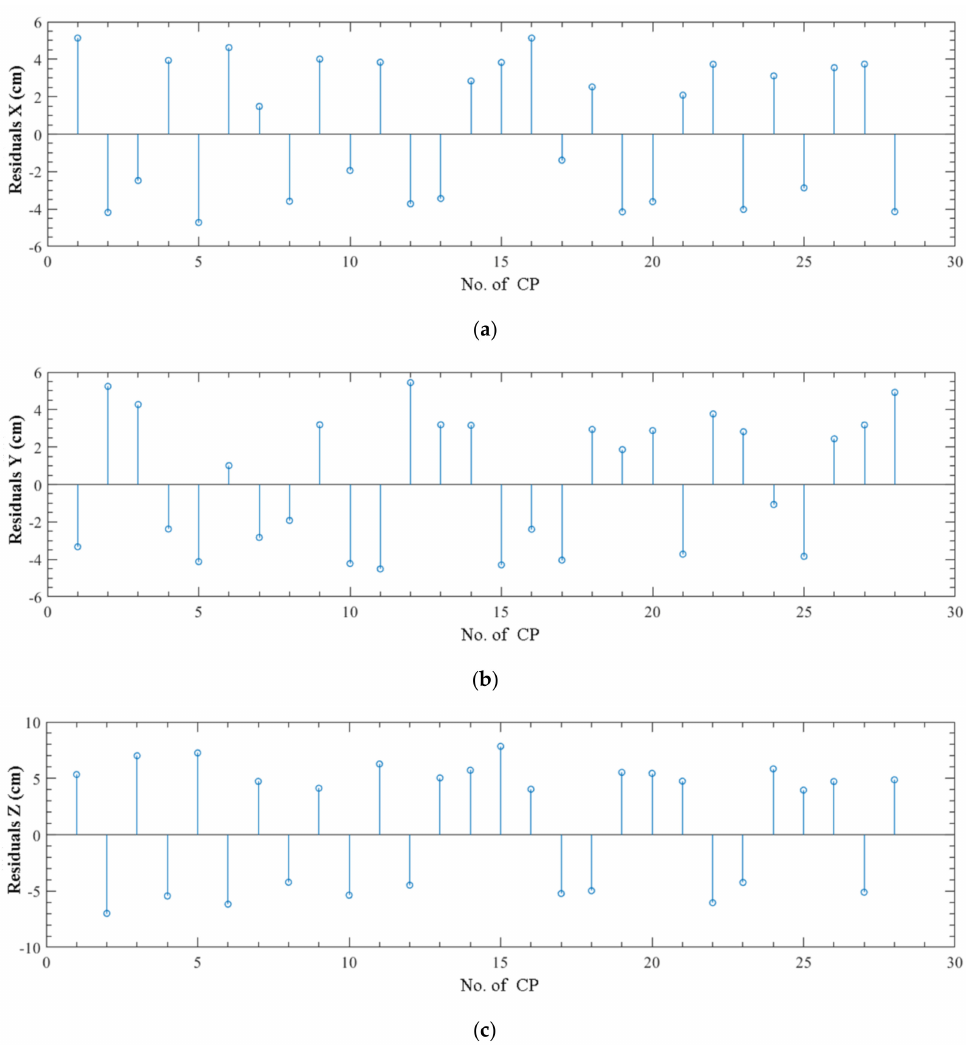
Figure 9. Residuals of 28 check points (CPs) for Part 1 and Part 2 measured on real-time kinematic (RTK) GPS and their corresponding 3D points determined from the dense point clouds. Residuals X, Y, and Z are shown in ( a – c ) respectively. Table 2. Comparison of the re-projection errors RMSE img of CPs via Pix4Dmapper 4.4,